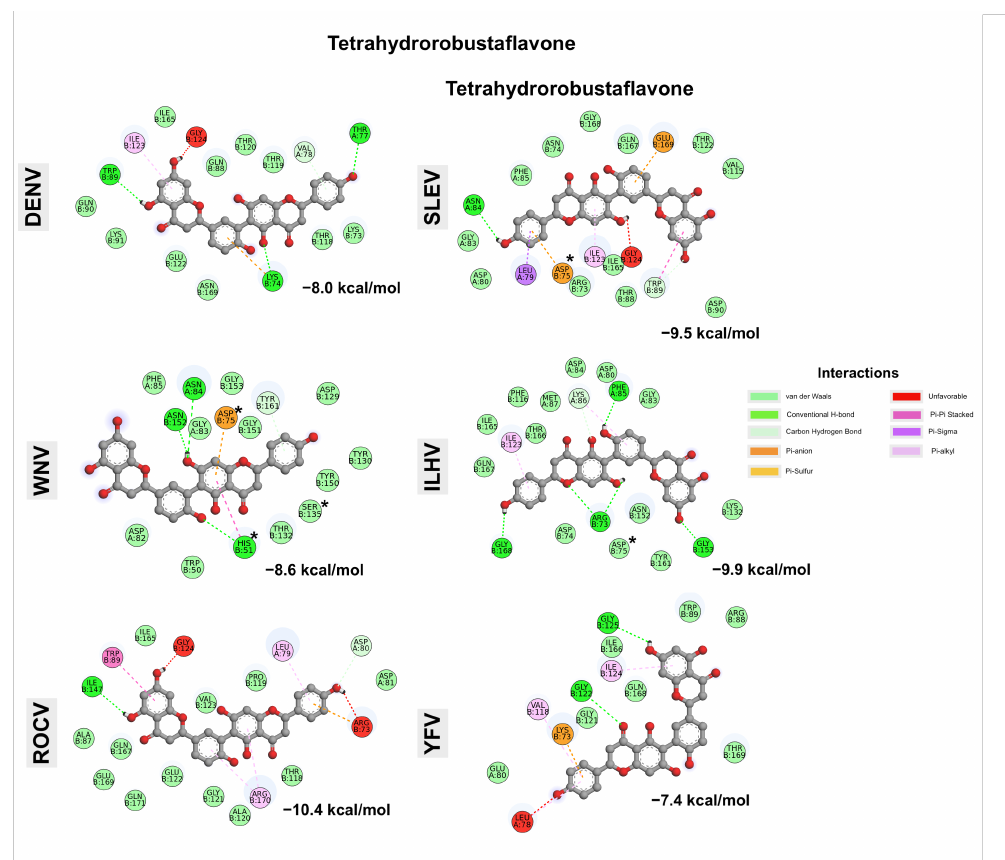
Figure 10. Interaction analysis of the best binding mode of tetrahydrorobustaflavone in the NS2B– NS3pro proteins of dengue virus (DENV), West Nile virus (WNV), Rocio virus (ROCV), Saint Louis encephalitis virus (SLEV), Ilhéus virus (ILHV), and yellow fever virus (YFV). The residues from the catalytic triad are marked with *. ILHV NS2B–NS3pro is represented by Cluster 1 only. Cluster 2 is shown in Figure